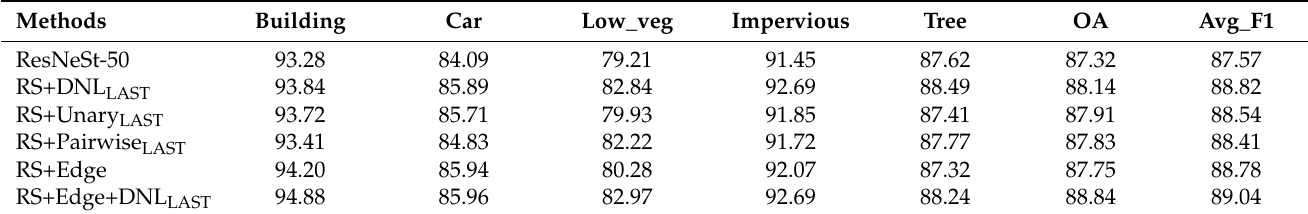
Table 4. Quantitative analysis (%) of the components in the proposed model based on the Vaihingen dataset. All results are based on an edge-erosion statistic.